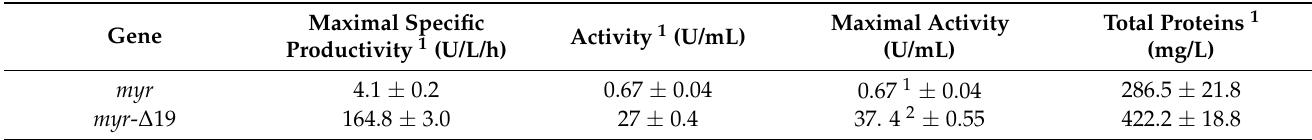
Table 1. The process parameters of the ( α -MF)-driven extracellular expression of myrosinase in Pichia pastoris with ( myr ) and without ( myr - ∆ 19) its native signal sequence in the expressed gene.